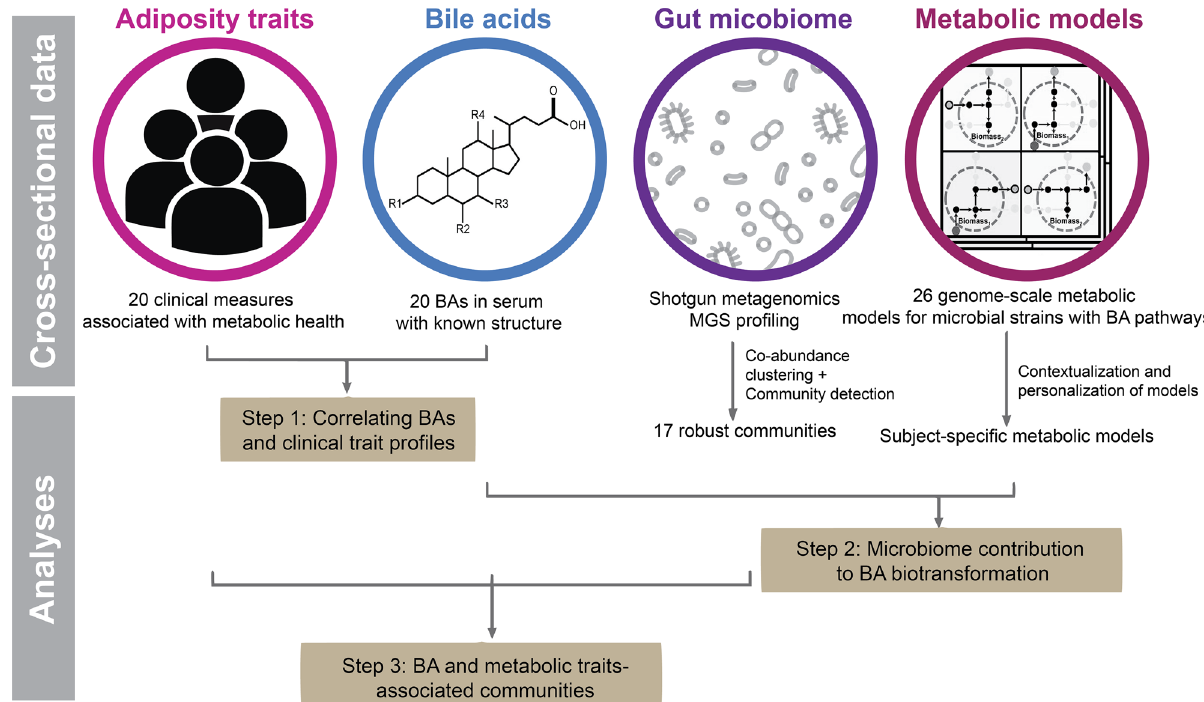
Figure 1. Framework for analyses of three complementary data sets: adiposity/metabolic traits, fasting serum bile acids and gut metagenomics species including search for bacterial enzymes or pathways involved in biotransformation of bile acids. The analysis addresses three main questions; (i) how does the serum bile acid composition relate to markers of host metabolic health? (ii) search for microbial pathways involved in bile